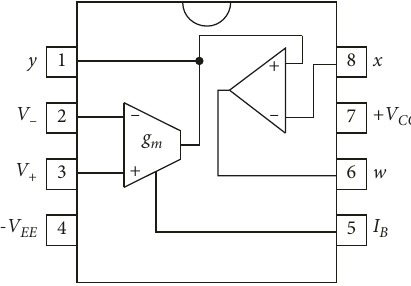
Figure 2: An 8-pin dual-in-line package of LT1228.